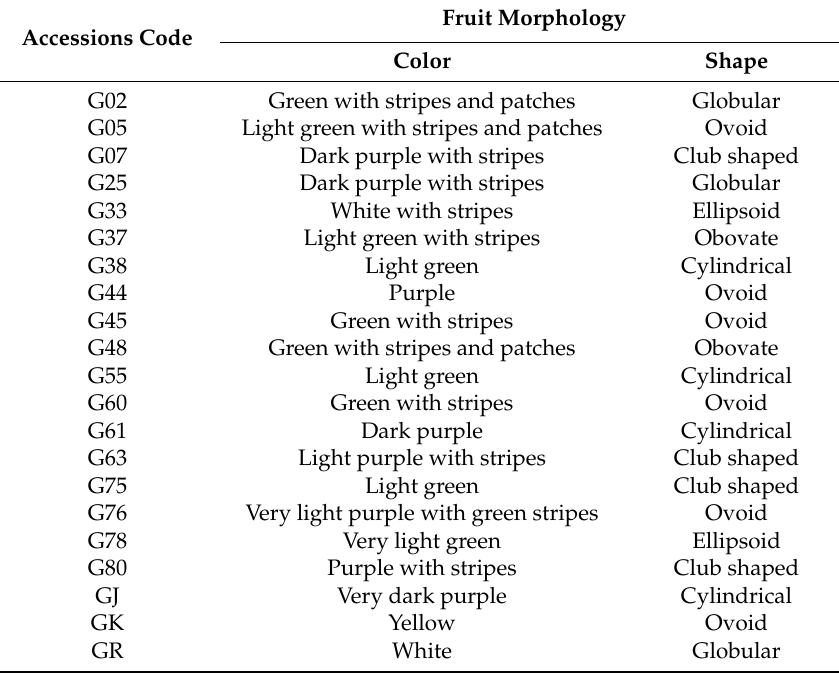
Table 4. Description of 21 eggplant accessions from the Center for Tropical Horticulture